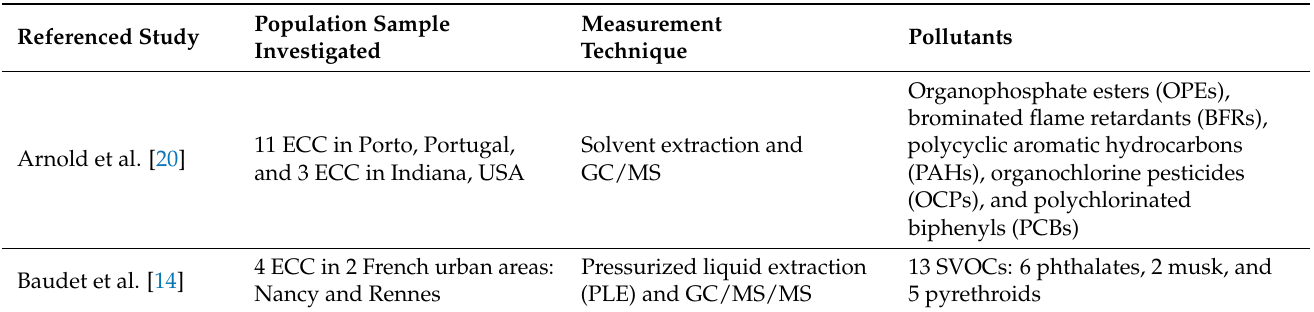
Table 3. Measurements of Emergent Compounds conducted in Elderly Centers